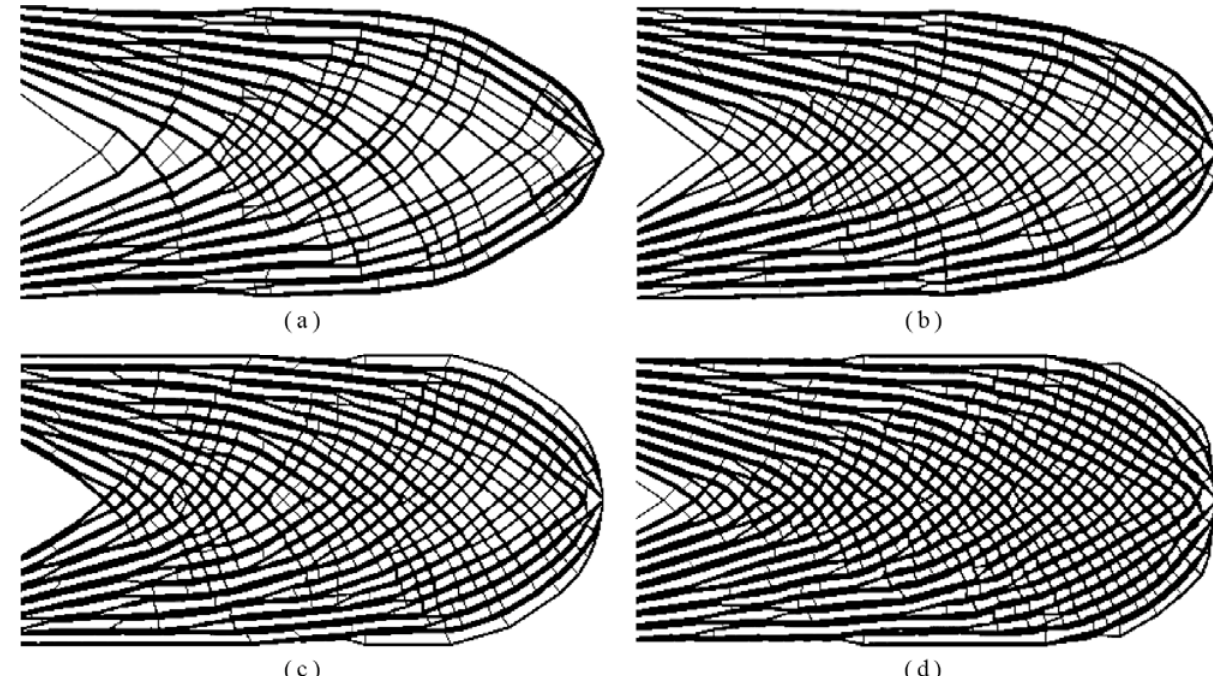
Figure 4. The optimized topologies by varying the global volume fraction from: ( a ) ψ = 0.35: c = 104.069, V f = 0.350, max ρ = 0.595 ; ( b ) ψ = 0.40: c = 94.551, V f = 0.401, ( d ) ψ = 0.50: c = 87.399, V f = 0.502, max